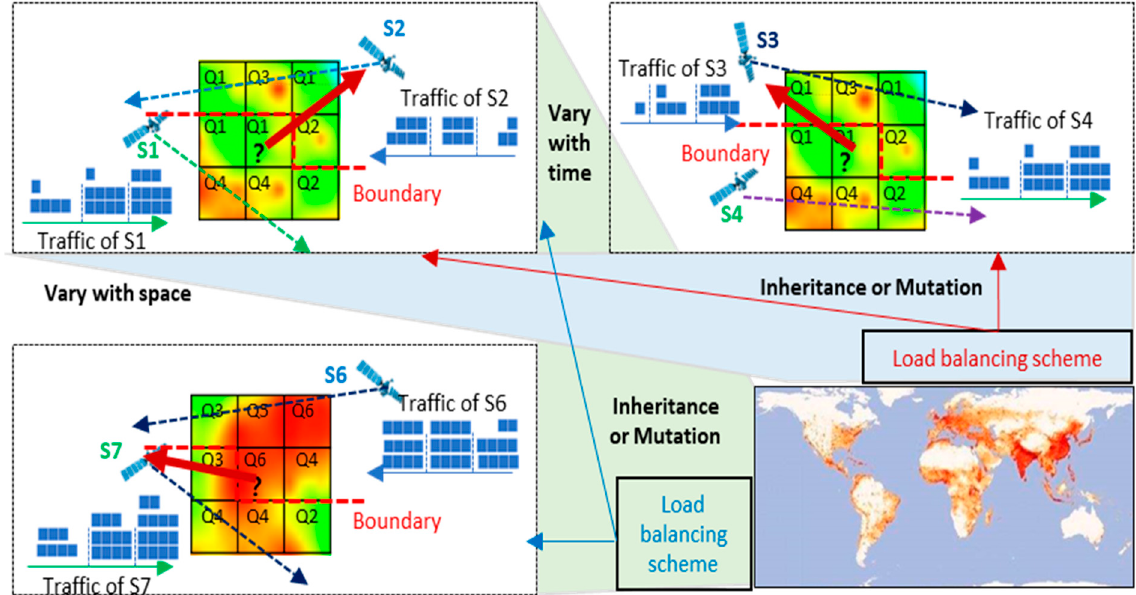
Figure 5. Inheritance or mutation of genetic control considering temporal variation.